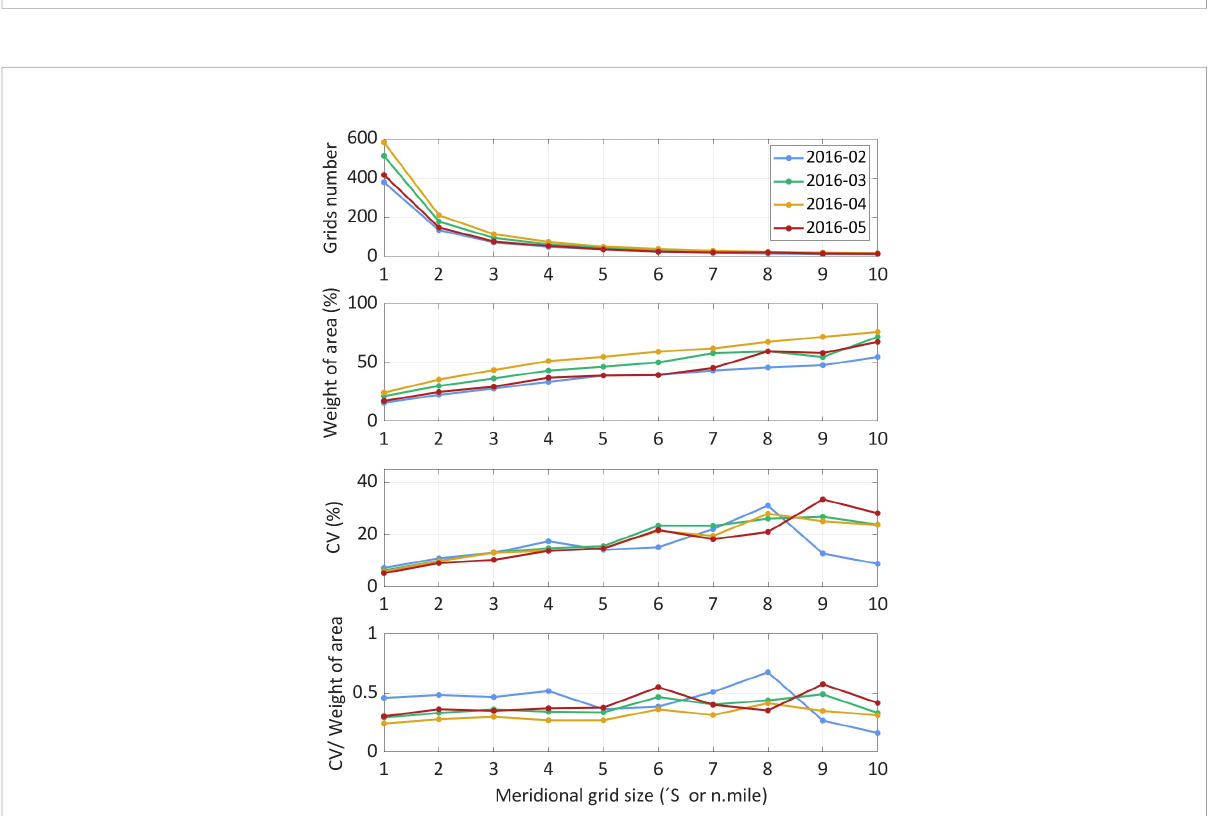
FIGURE 4 Gridded sample number, weight of effective covered area, coef fi cient of variation of the nautical area scattering coef fi cient (NASC), and grid selection index for different grid